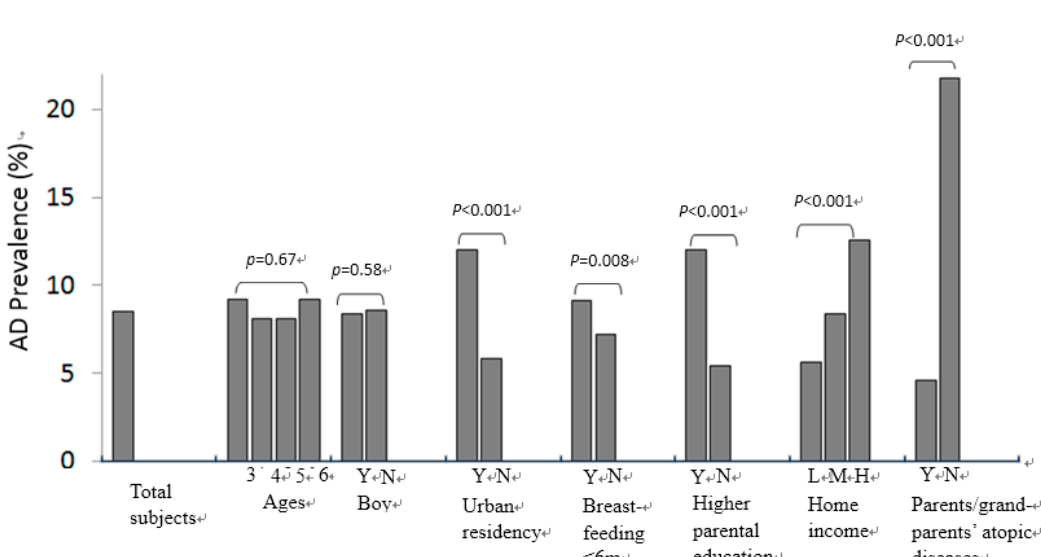
Figure 2. Comparisons of AD prevalence between ages, gender, residency area, breastfeeding, parental educational level, home economy and parents/grandparents’ history of atopic diseases. Y = yes; N = no. Higher parental education (Y = both parents with college-level education) vs. lower parental education (N = either one parent did not have college-level education); Home economy (H = higher, M = middle, L = lower). Table 2. Association (AORs and 95% CI) between childhood AD and demographic and home environmental factors in total subjects and subgroups with and without parents/grandparents’ atopic diseases †